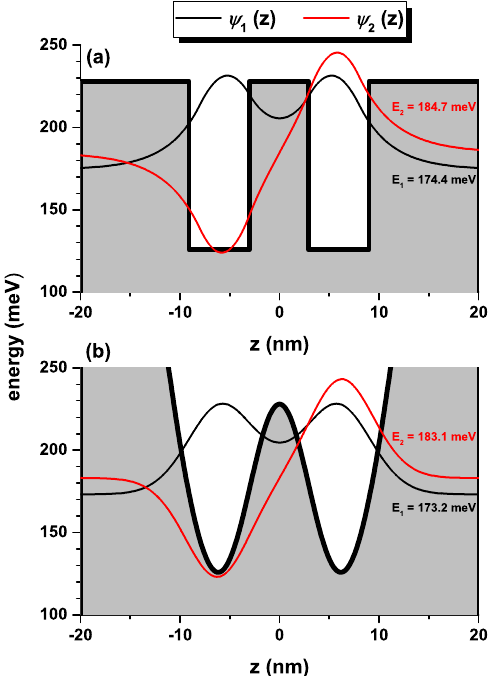
Figure 8. The ground and the first excited states wave functions for a confined electron in rectangular shaped ( a ) and harmonic-Gaussian ( b ) symmetric double quantum wells. The corresponding energies are also